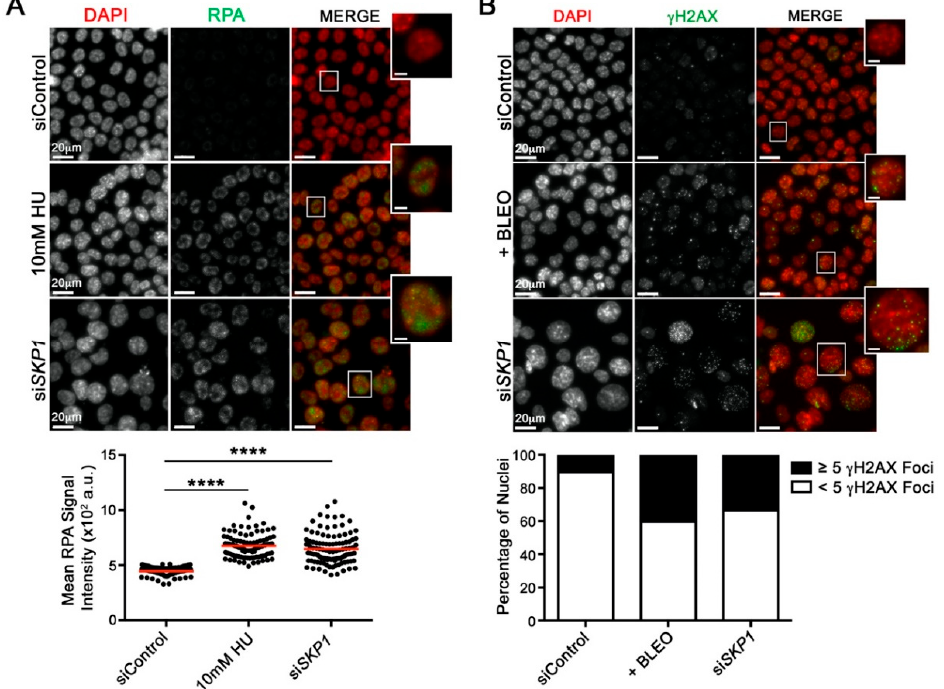
Figure 4. SKP1 Silencing Induces Replication Stress and DNA Damage. ( A ) Representative maximum intensity projections (top; micrographs) showing visual increases in Replication Protein A (RPA) labeling in HCT116 cells following SKP1 silencing relative to siControl; hydroxyurea (HU) is a positive control. Note that all images were acquired using identical exposure times. For illustrative purposes, a single nucleus is magnified from each condition (bounding box; scale bar represents 5 µ m). ScQuantIM (bottom; dot plot) reveals significant increases in mean RPA signal intensity following SKP1 silencing (or HU treatment) relative to siControl (Student’s t -tests; **** = p -value < 0.0001). ( B ) Qualitative images (top; micrographs) showing visual increases in γ H2AX labeling in HCT116 cells following SKP1 silencing relative to siControl; bleomycin (BLEO) is a positive control. Note that all images were acquired using identical exposure times. A single nucleus is magnified from each condition (bounding box; scale bar represents 5 µ m). ScQuantIM (bottom; bar graph) reveals a 3.2-fold increases in the percentage of nuclei harboring ≥ 5 γ H2AX foci (black) following SKP1 (33.5%) silencing relative to siControl (10.4%); bleomycin treatments increased 3.9-fold